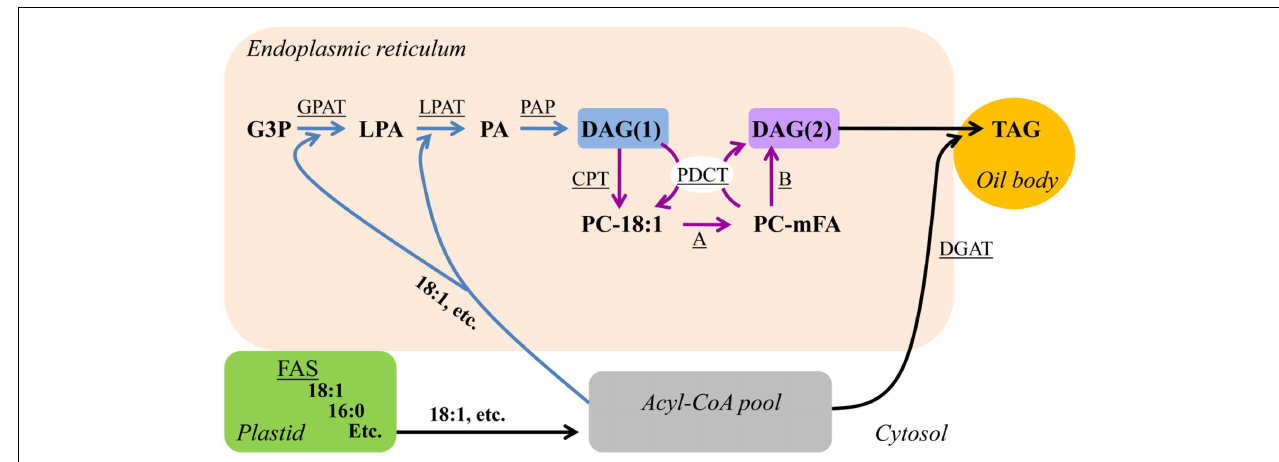
triacylglycerol. Enzymatic reactions are underlined: A, modification of FA esterified to PC; B, reversible CPT or phospholipase C or phospholipase D/PAP DAG production. CPT, CDP-choline:DAG cholinephosphotransferase; DGAT, acyl-CoA:DAG acyltransferase; FAS, fatty acid synthesis; GPAT, acyl-CoA:G3P acyltransferase; LPAT, acyl-CoA:LPA acyltransferase; PAP, PA phosphatase; PDCT, PC:DAG